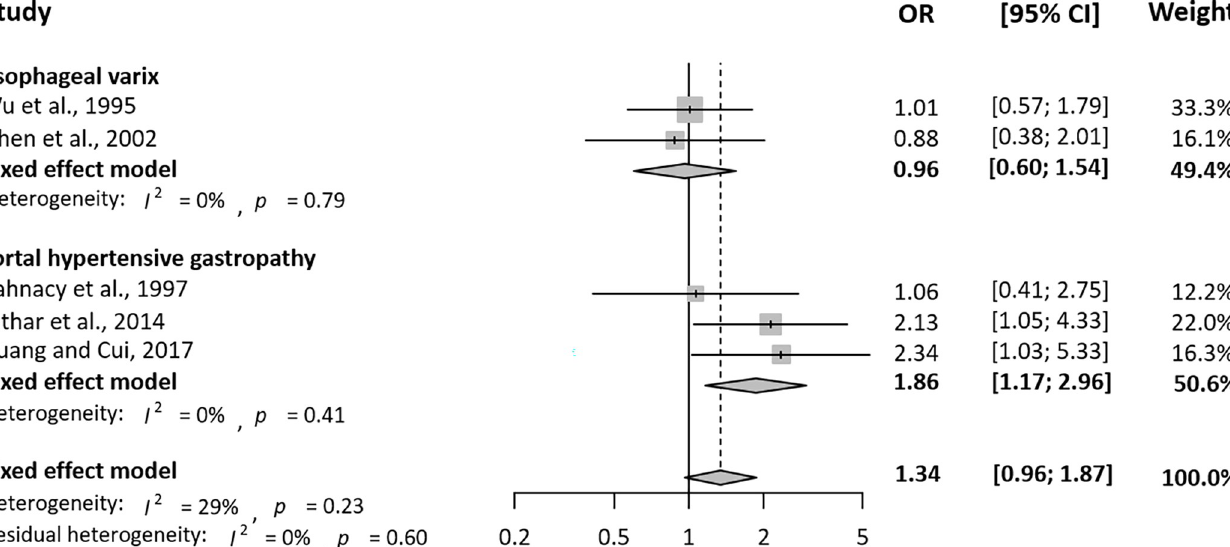
Fig 3. Unadjusted odds ratio and 95% confidence interval of portal hypertension-related gastrointestinal complications by Helicobacter pylori infection in five case-control studies. OR, odds ratio; CI, confidence interval.